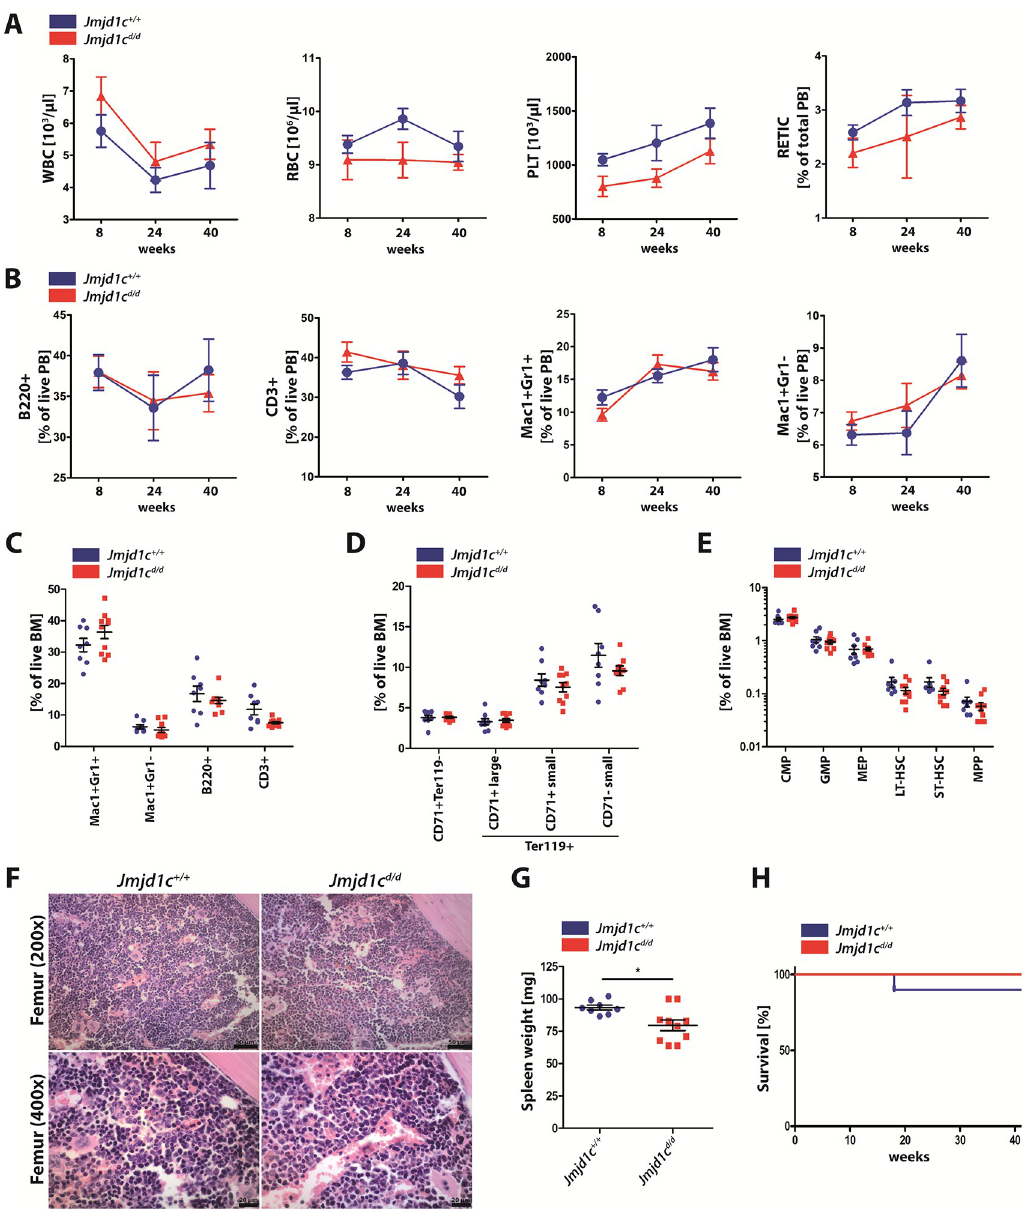
Fig 4. Loss of Jmjd1c is dispensable for steady-state hematopoiesis. (A-H) Blood draws of Jmjd1c d/d mice and wt controls (n = 10 per genotype, lost data points are shown in S2 Table) were performed after 8, 24 and 40 weeks with subsequent sacrifice for final analysis of BM and SPL tissue. (A) White blood cell (WBC) count, red blood cell (RBC) count, platelet (PLT) count and the percentage of reticulocytes. (B) FACS staining for mature blood cells in PB samples: B cells (B220), T cells (CD3), mature granulocytes (Mac1-Gr1) and monocytes (Mac1). (C-E) FACS staining for mature blood cells (C) , erythroid precursors (D) and HPSC (E) in BM samples. (F) Representative H&E staining of formalin-fixed and paraffin-embedded femur of wt control (left) and Jmjd1c d/d mice (right). Scale bars: 50 μ m (top) and 20 μ m (bottom). (G) Spleen weight of 40-week-old mice. (H) Survival curve. Data are represented as mean +/- SEM in A-E and G . � P < 0.05. Mann-Whitney U test was used for statistical calculations. Kaplan-Meyer survival analysis was used to determine survival